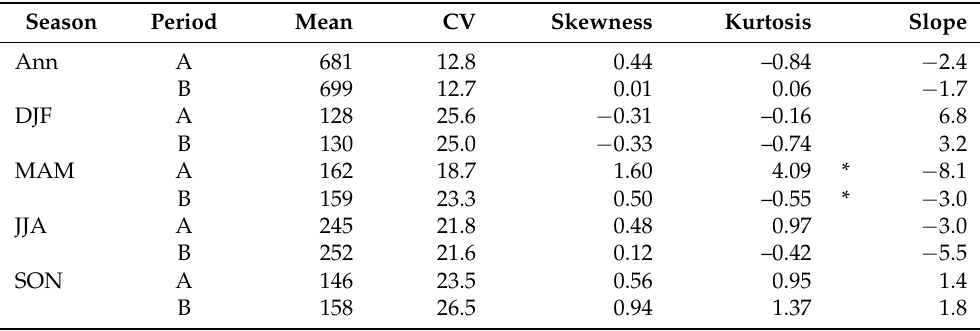
Table 7. Selected statistical characteristics of annual (Ann) and seasonal (DJF, MAM, JJA, and SON) series of mean precipitation totals in the Czech Republic in the 1961–1990 (A) and 1991–2020 (B) periods: means are in mm, coefficients of variation (CV) in %, linear trends in mm/10 years (none statistically significant at the 0.05 significance level). An asterisk * indicates statistically significant differences of a given characteristic between two 30-year